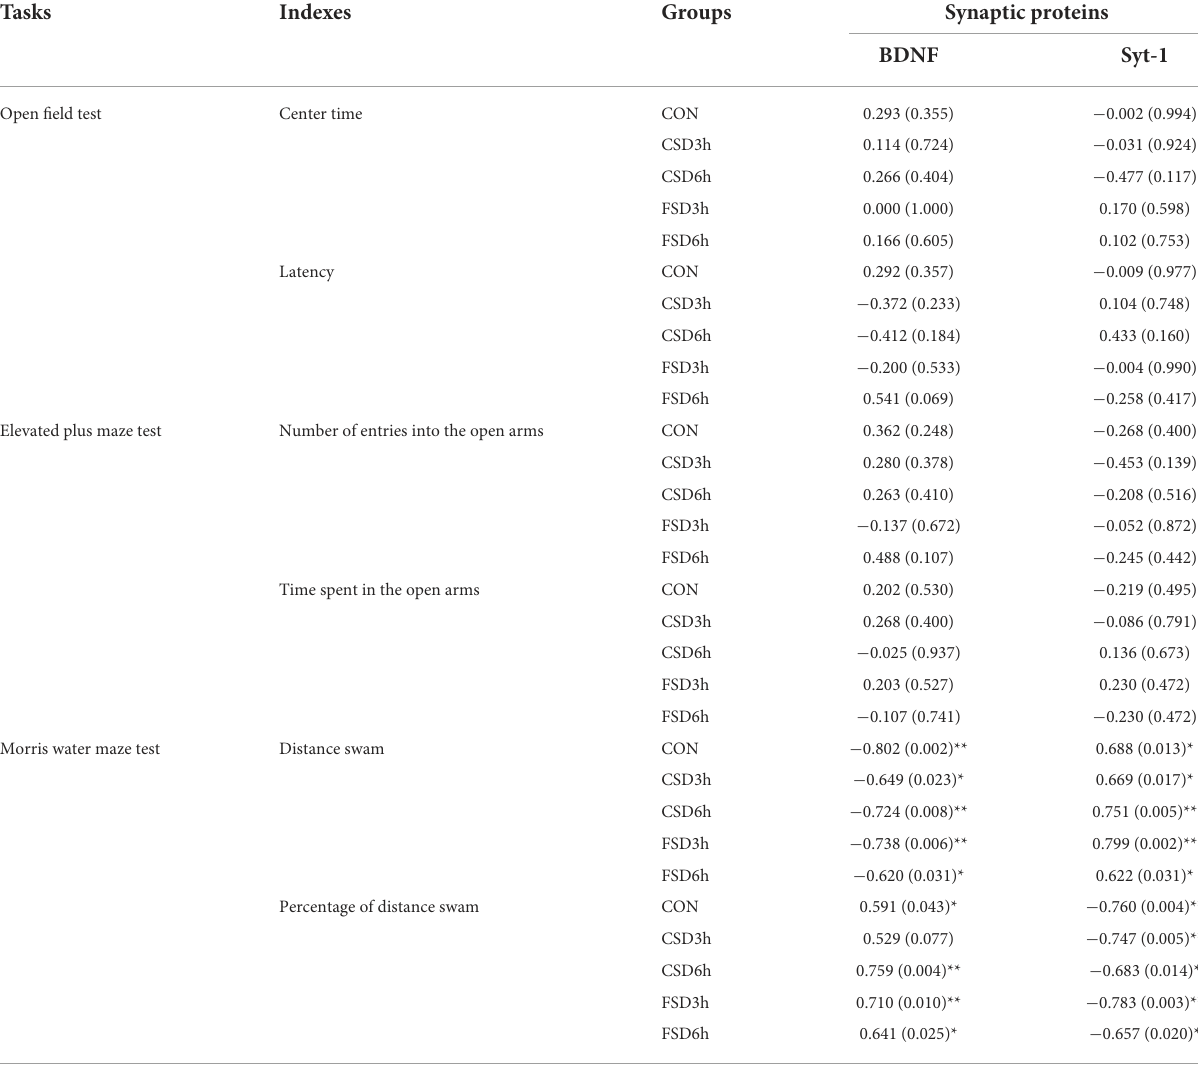
TABLE 2 Correlation between the performance in the anxiety/cognition-related tasks and levels of hippocampal synaptic proteins [ r ( p )].